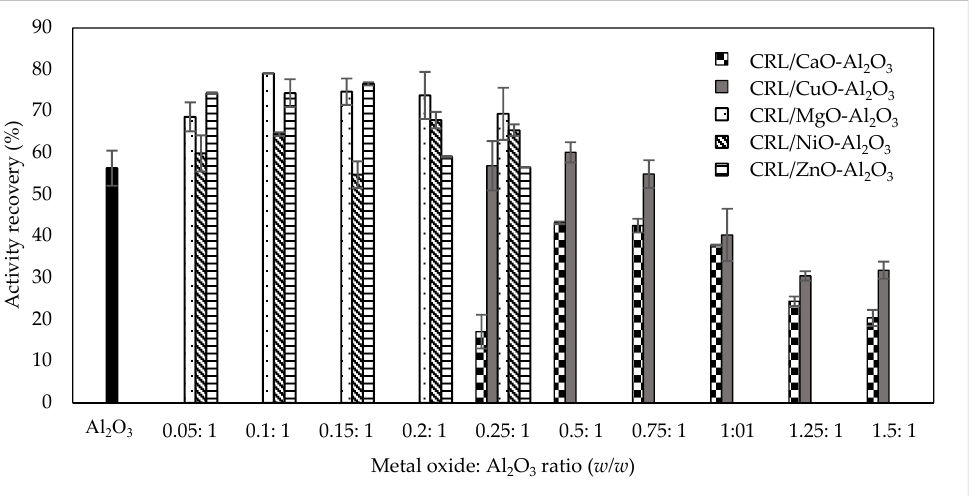
Figure 1. Effect of MO: Al 2 O 3 ratio on activity recovery.